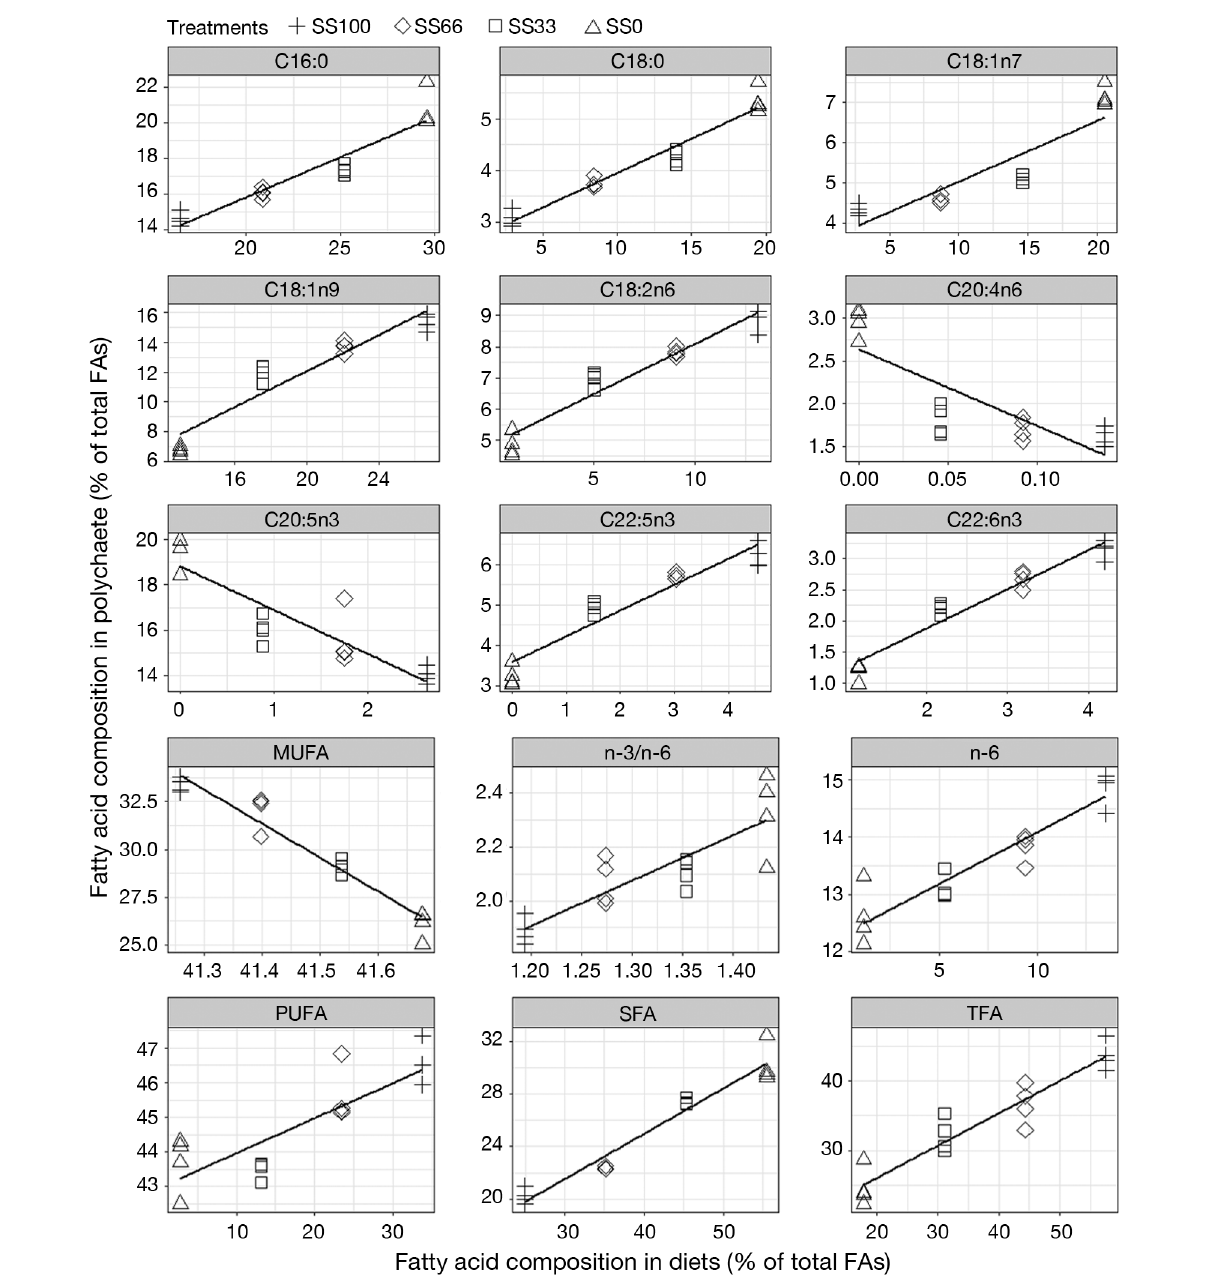
Fig. 6. Relationship between fatty acid (FA) composition of the experimental diet and fatty acid composition of Hediste diver- sicolor after the 30 d experimental period. See Fig. 1 for treatment definitions; MUFA: monounsaturated FA; PUFA: polyun- saturated FA; SFA: saturated fatty acid; TFA: total FA. The FA values in each diet treatment are the mean values of each diet; SS66 and SS33 were calculated according to the ratio of